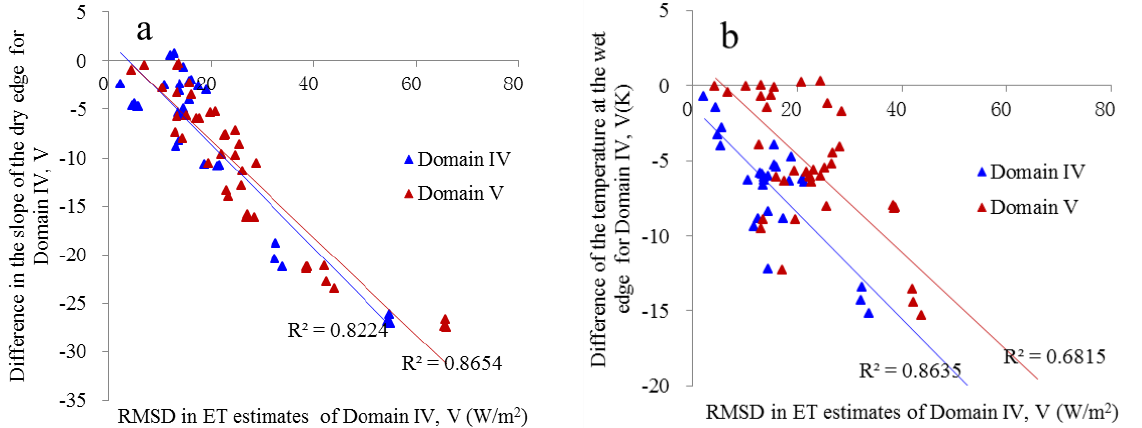
Figure 5. Comparisons of RMSD in ET estimates of Domain IV and Domain V between different domain scales and the difference of the boundary conditions of the T ( a ) difference in the slope of the dry edge; ( b ) difference of the temperature at the wet